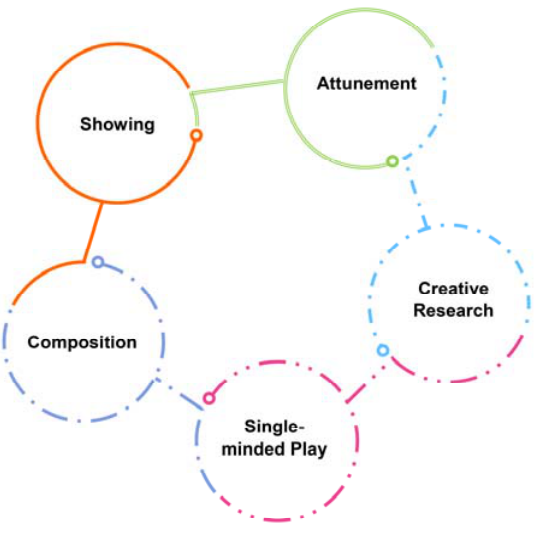
Figure 1. The process sequence of Art Hacking.